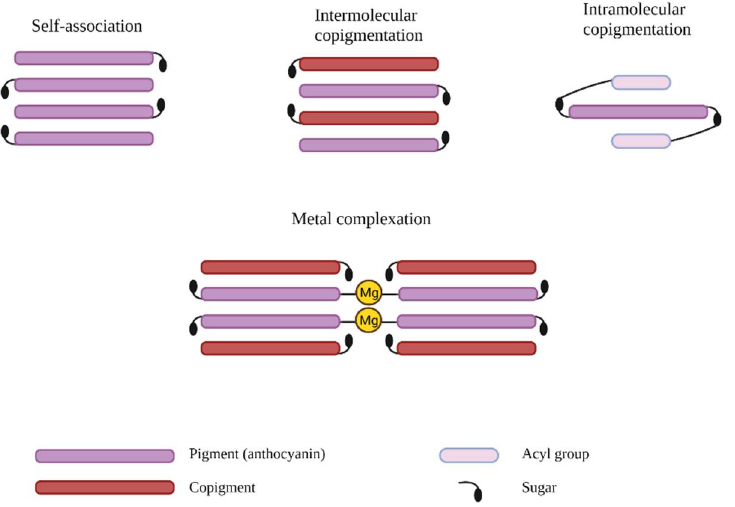
Figure 5. Types of anthocyanin co-pigmentation.